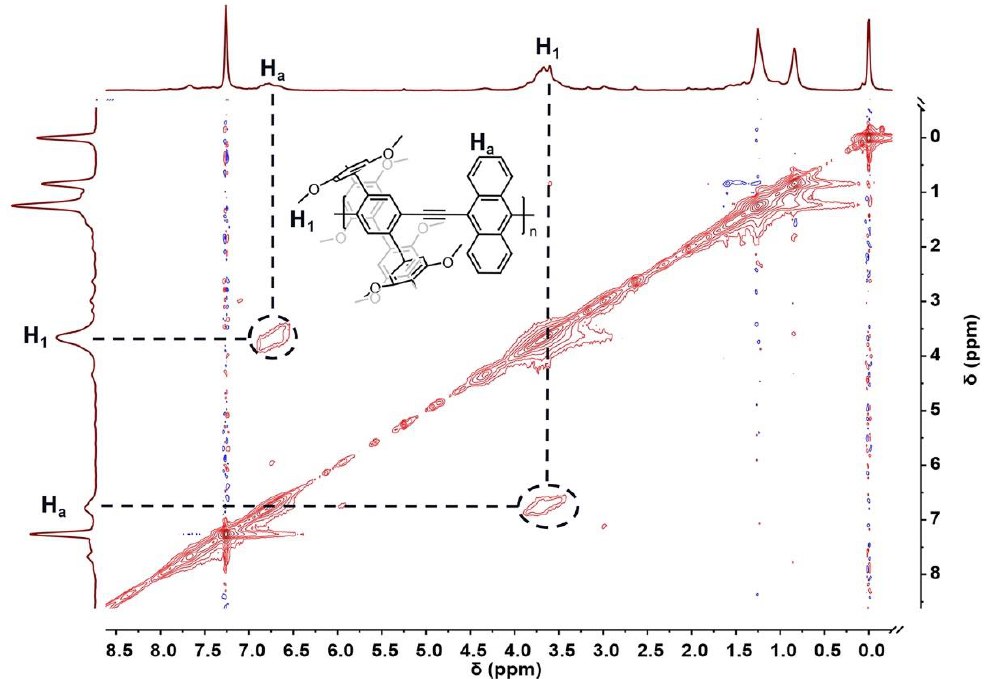
Figure 2. Two-dimensional ROESY spectrum (600 MHz, CDCl 3 , 298 K) of p(P[5](OTf) 2 - co -9,10-